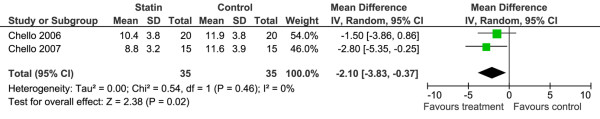
Forest plot of comparison for prophylactic statin therapy versus standard care/placebo: Inflammatory markers, outcome: TNF-α.  Total refers to no. of patients per trial. CI = confidence interval; SD = standard deviation.